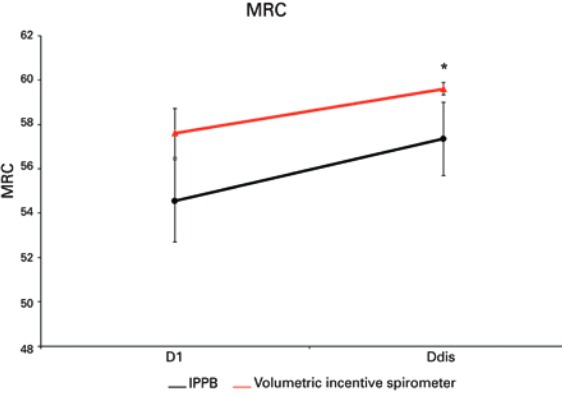
Assessment of overall muscle strength performed on the first (D1) and last (Ddis) respiratory therapy session before discharge from the intensive care unit